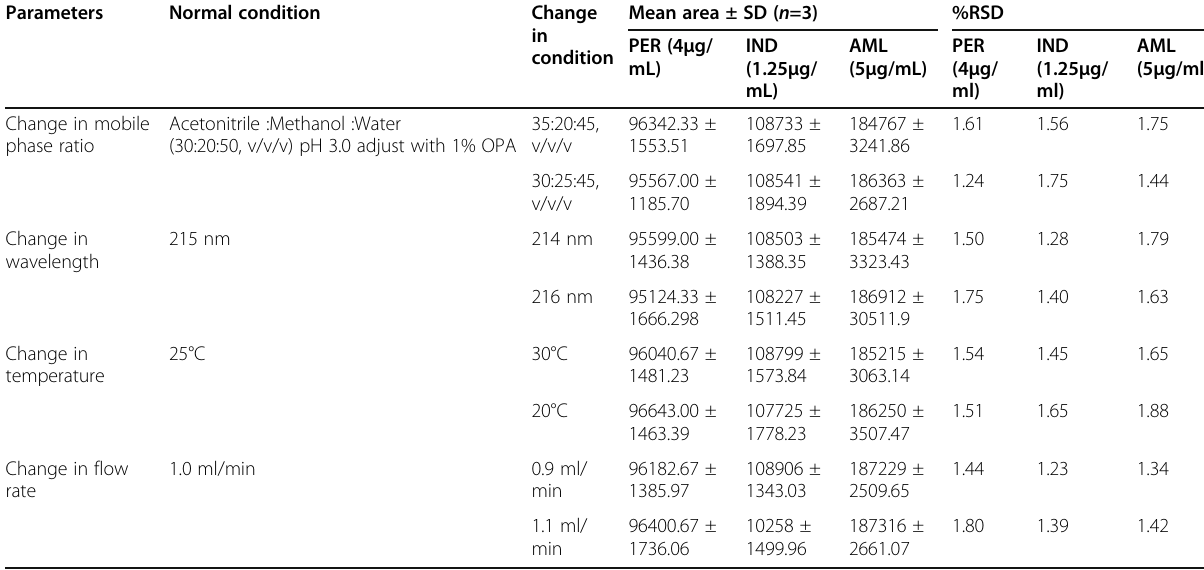
Table 3. Robustness study of proposed